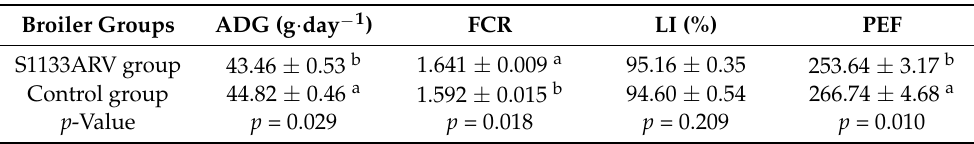
Table 2. Performance variables of female broiler chickens vaccinated with the avian reovirus S1133 strain.